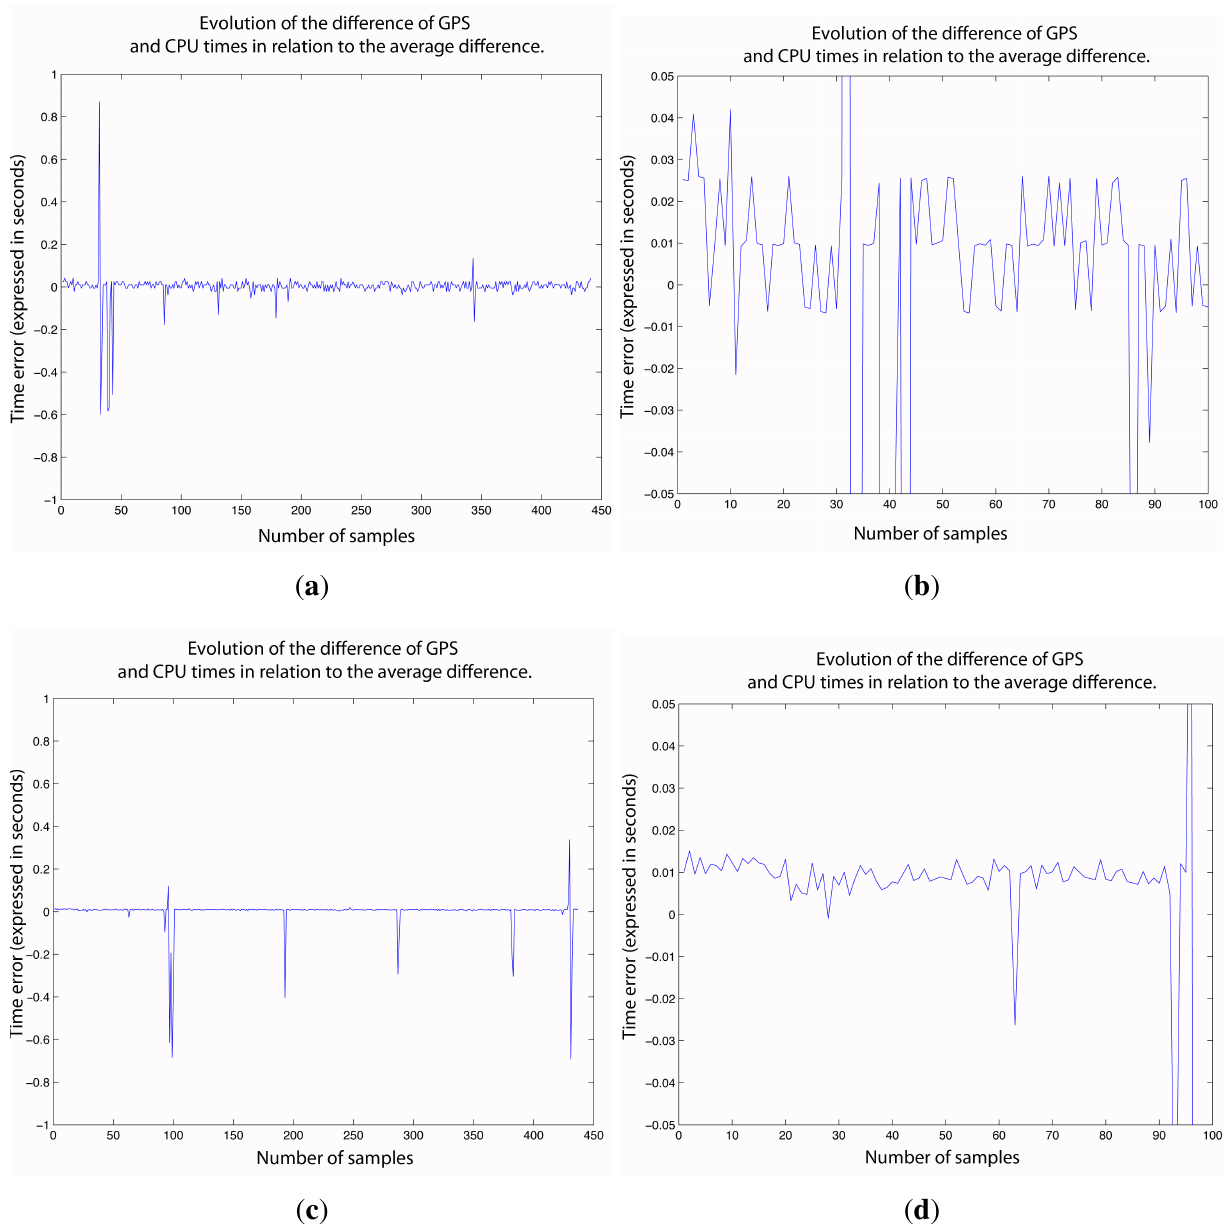
Figure 9. Synchronization errors in the operating systems. ( a ) Time error in Windows OS; ( b ) zoom on Figure 9a; ( c ) time error in Mac OS X, Snow Leopard; ( d ) zoom on Figure